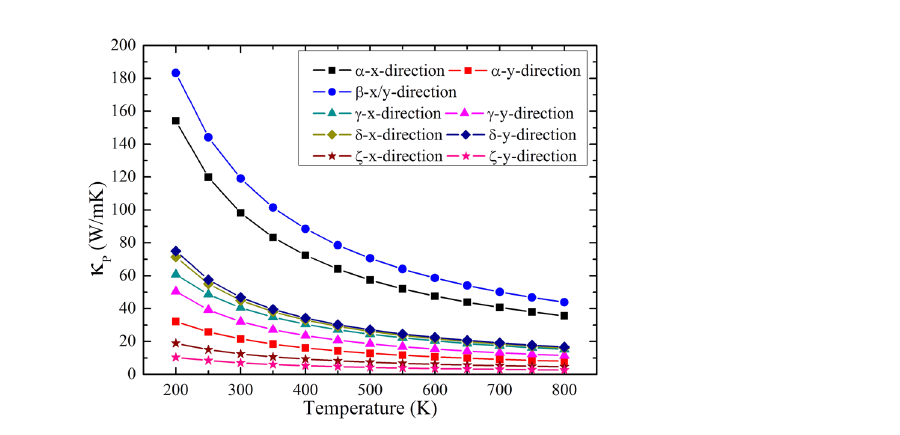
Figure 3. The phonon dispersion relations of ( a ) α -phosphorene, ( b ) β -phosphorene, ( c ) γ -phosphorene, ( d ) δ -phosphorene, and ( e ) ζ -phosphorene. The highlighted areas are calculated phonon gaps with values of 0.92, 3.41, 0.35, 0.22, and 0.47 THz, respectively.